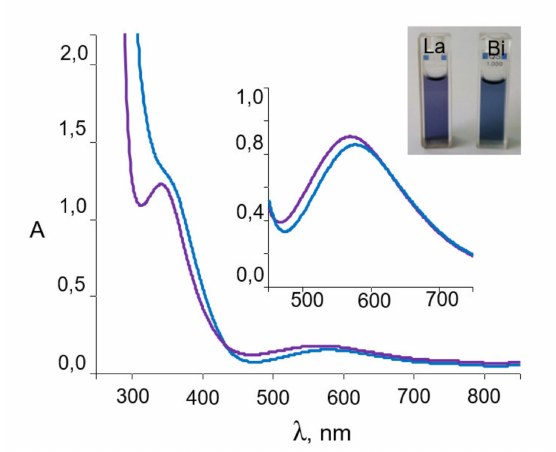
Figure 1. UV-vis spectra of the aqueous solution of 1 (blue) and the analogous La complex (violet). Inset: Spectra at 575 nm (2.3 × 10 − 3